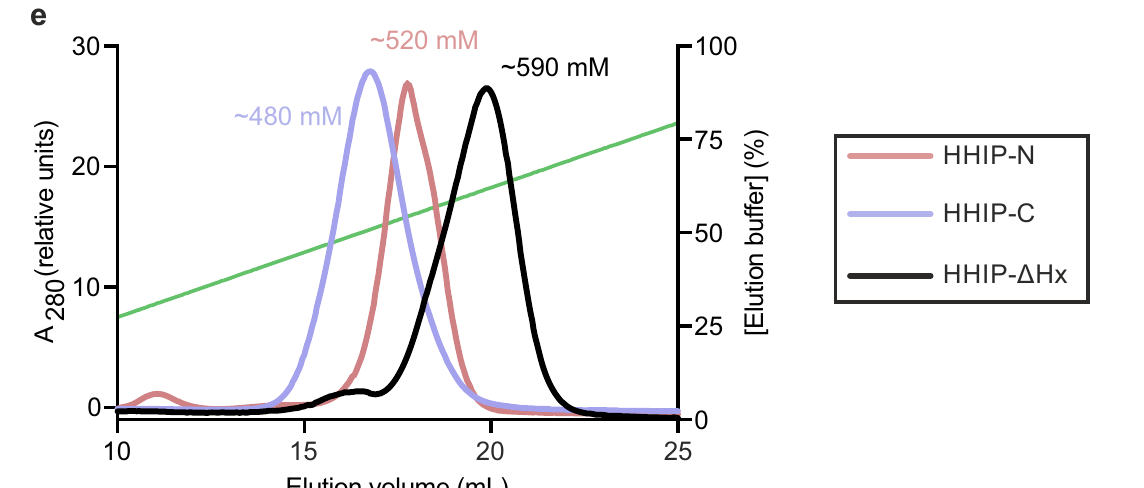
Fig. 3 HHIP-N:GAG interactions. a , b Comparison of the apo HHIP-N structure ( a ) and HHIP-N:SOS complex. Colour coding is as in Fig. 1b. For HHIP- N:apo, the disordered GAG-binding domain is shown as a dashed line. In the HHIP-N:SOS complex three SOS molecules interact with the GAG-binding domain. c Electrostatic surface potential of the HHIP-N:SOS complex, displayed from − 10 kT/e to + 10 kT/e. d Close-up view of HHIP-N:SOS binding site showing the region marked in C. Hydrogen bonds are shown as dashed lines ( c , d rotated 90 ° around the x-axis relative to B). Mutations previously observed to decrease GAG-binding af fi nity and cause dysfunction of HHIP are marked with asterisks 28 . e Heparin af fi nity chromatography of different HHIP constructs eluted from a linear gradient of NaCl from 20 to 1000mM (green line). Traces corresponding to different constructs are coloured according to the accompanying legend